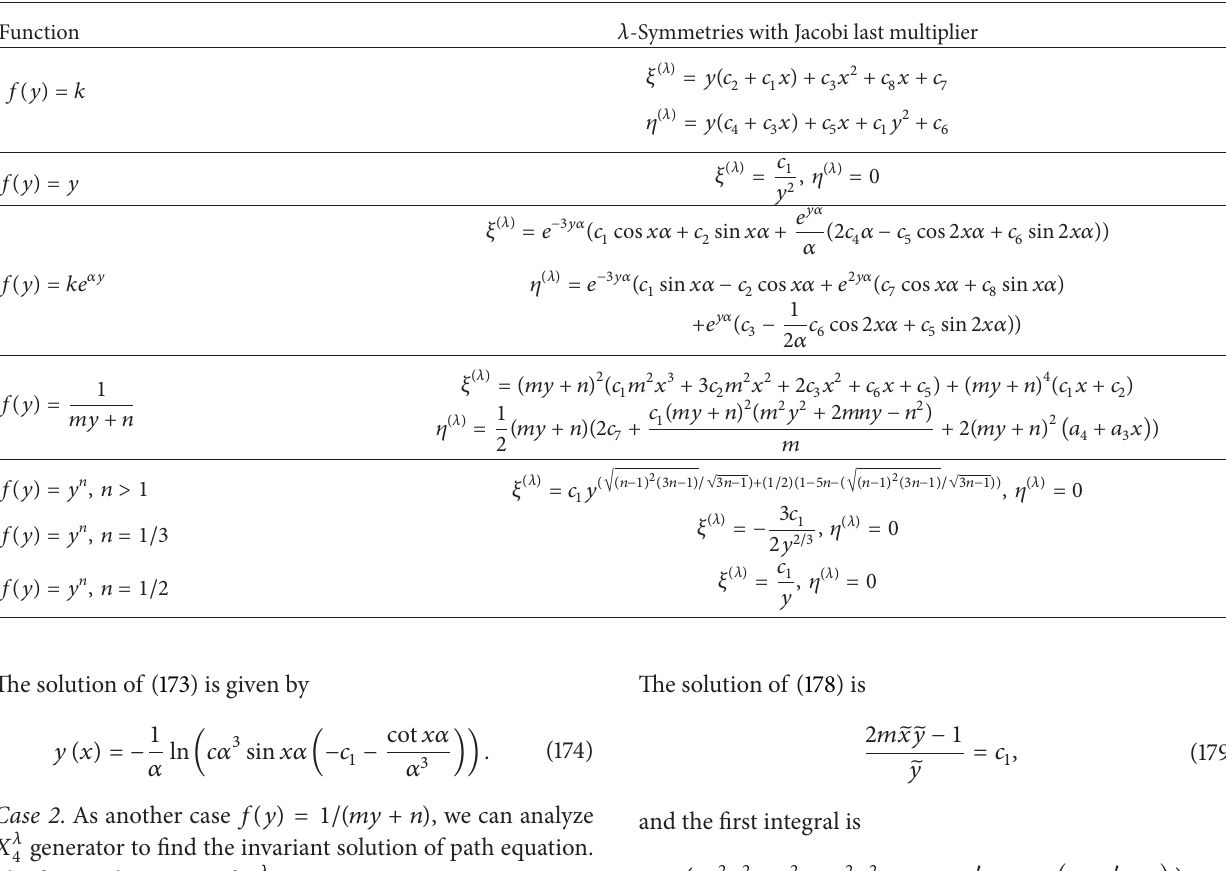
Table 3: 𝜆 -Symmetry classification table of path equation with Jacobi last